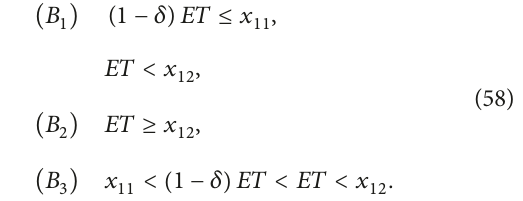
Λ 2 at two points ) . Thus, Is is I and we obtain the Ps P 𝑚𝑎𝑥